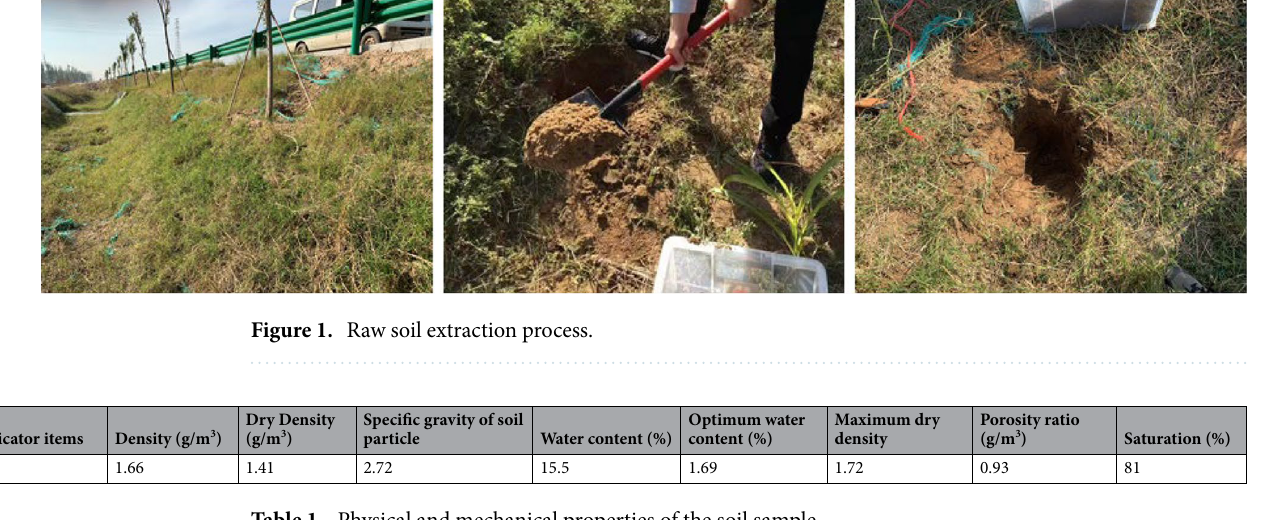
Table 1. Physical and mechanical properties of the soil